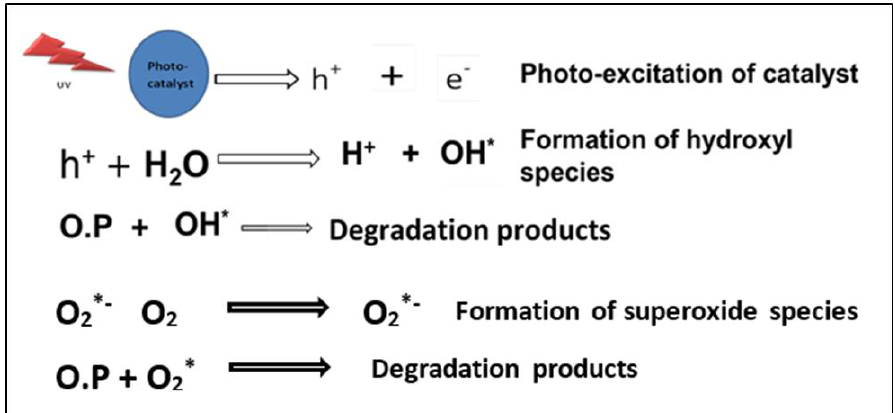
Figure 1. Stages in organic pollutant (O.P) degradation in photo-catalysis.